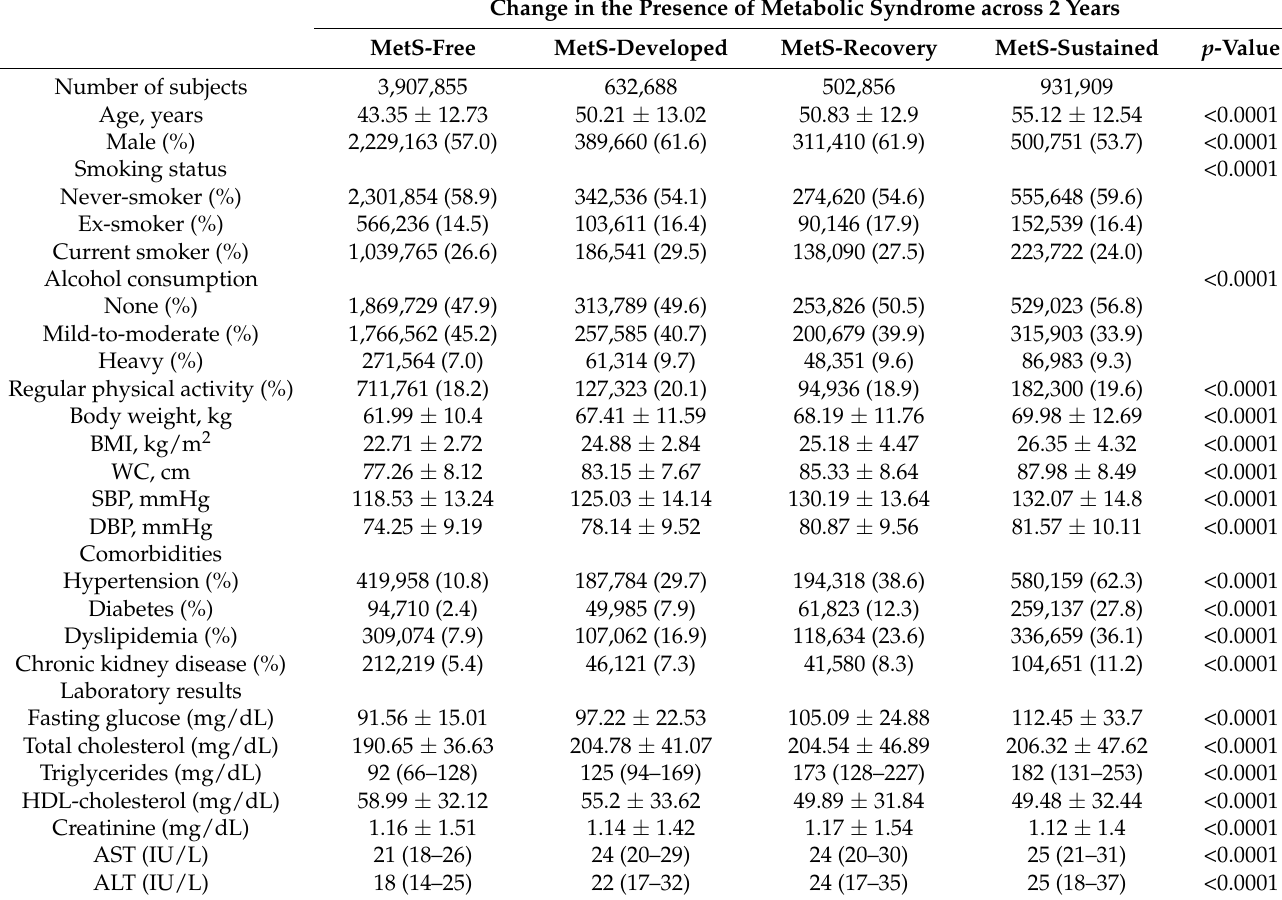
Table 1. Baseline characteristics of the study